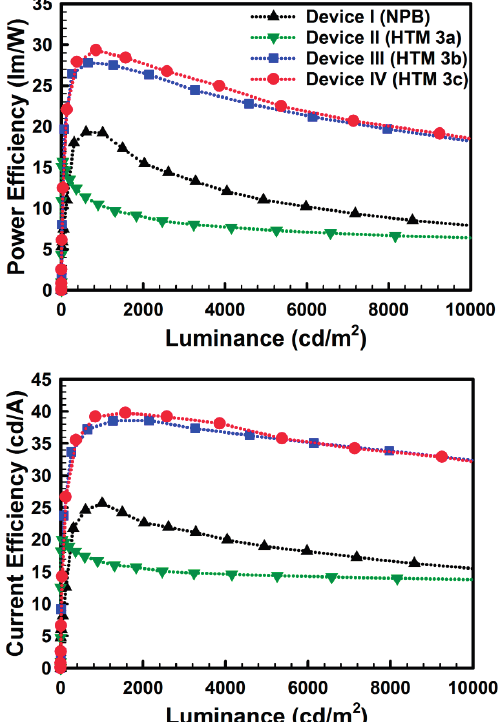
Figure 4. Power & current efficiencies of the fabricated OLEDs.